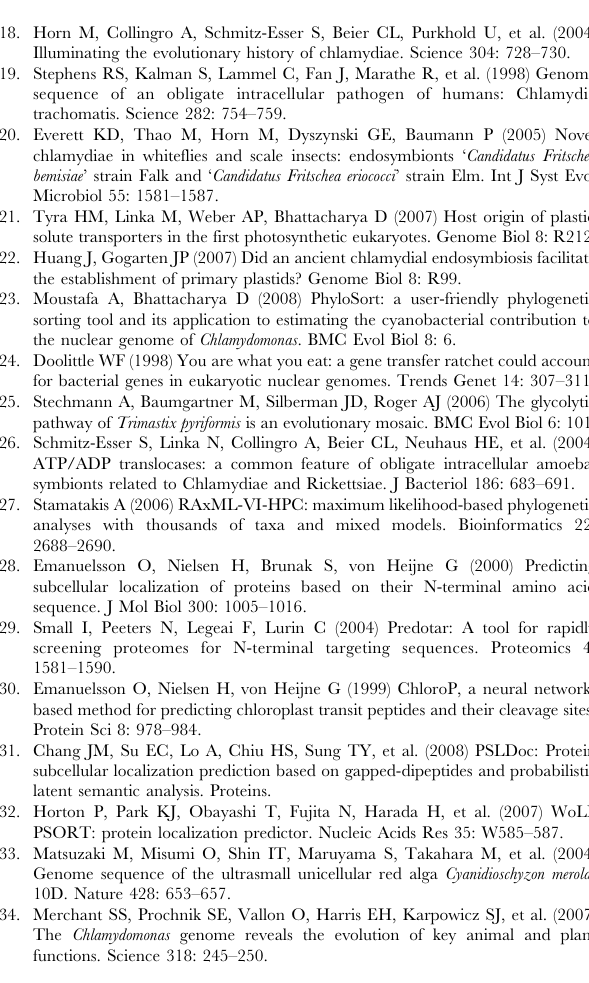
Table S1 The list of 55 genes of Chlamydiae-like origin that were found in the 17 Plantae genomes analyzed in this study using phylogenomic methods. Shown are the tree IDs, the source of the sequences, the GI/accession numbers in the source database, the gene annotations in that database, the Arabidopsis homolog GI numbers and putative functions, the Chlamydiae homolog GI numbers and putative functions, the minimum bootstrap value that unites Chlamydiae and Plantae in each protein tree, the distribution of the genes in Plantae (G, R, C, and X indicate presence in green algae/plants, red algae, chromalveolates, and glaucophytes, respectively), the results of targeting predicitions using 5 different programs, our inferred predictions for cellular localization, and the phylogenetic position of UWE25 in each protein tree (i.e., Y, when UWE25 was sister to the Plantae and N, when not).